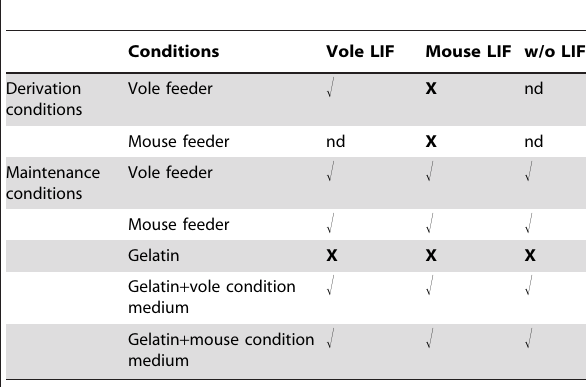
Table 1. Specific conditions for derivation and maintenance of vole TS-like